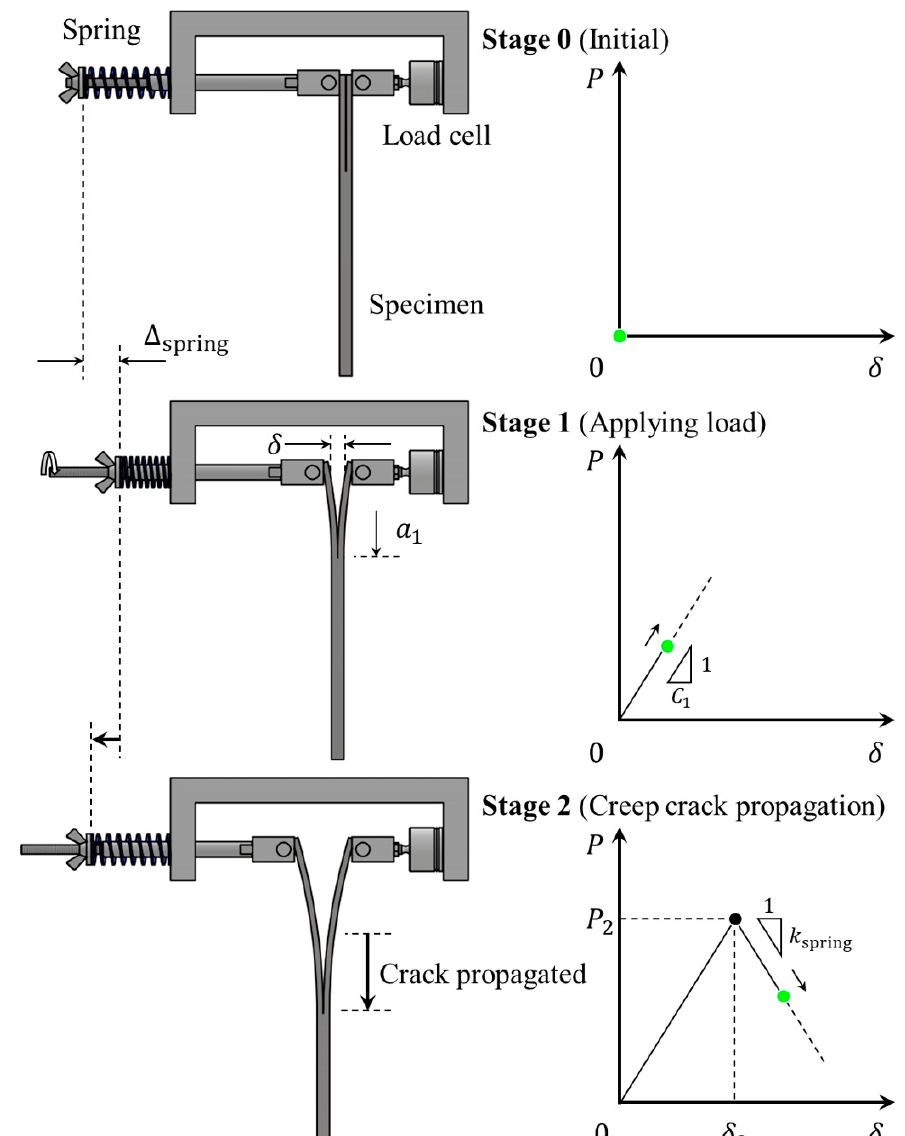
Figure 1. Schematic diagram of a spring-loaded DCB test: stage 0—before a test; stage 1—load applying process by tightening a nut; stage 2—creep load applying process.